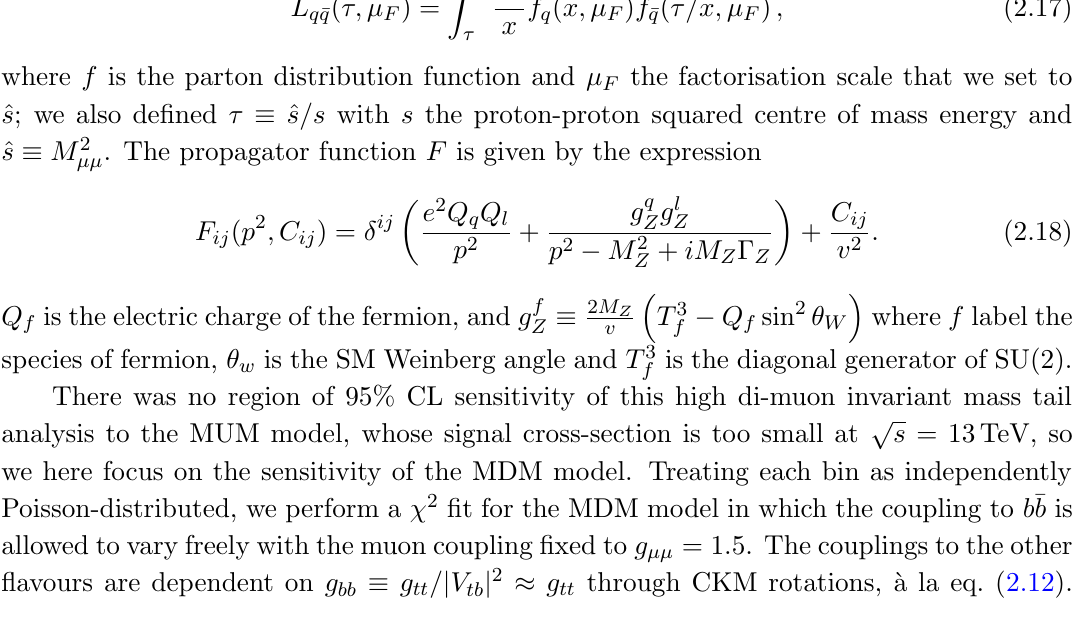
Figure 4 . (cid:1) (cid:31) 2 for the four-fermion coe(cid:14)cient C tt ’ C bb = (cid:0) g bb g (cid:22)(cid:22) v 2 =M 2 13 TeV 36.1 fb (cid:0) 1 di-muon distribution in the MDM model. The high-luminosity LHC projections are shown in dashed